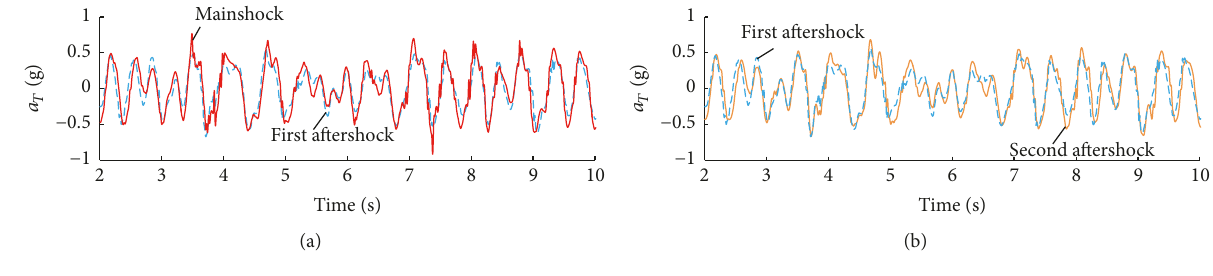
Figure 14: Effect of aftershocks on the structural acceleration.